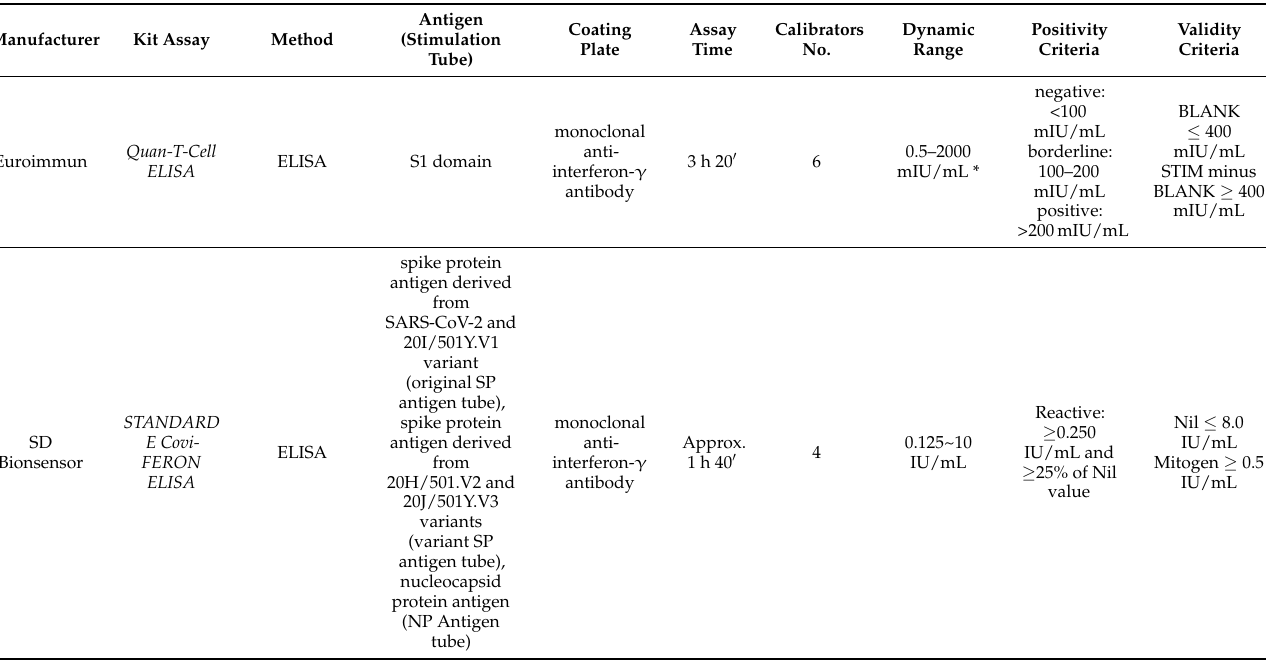
Table 3. Characteristics of